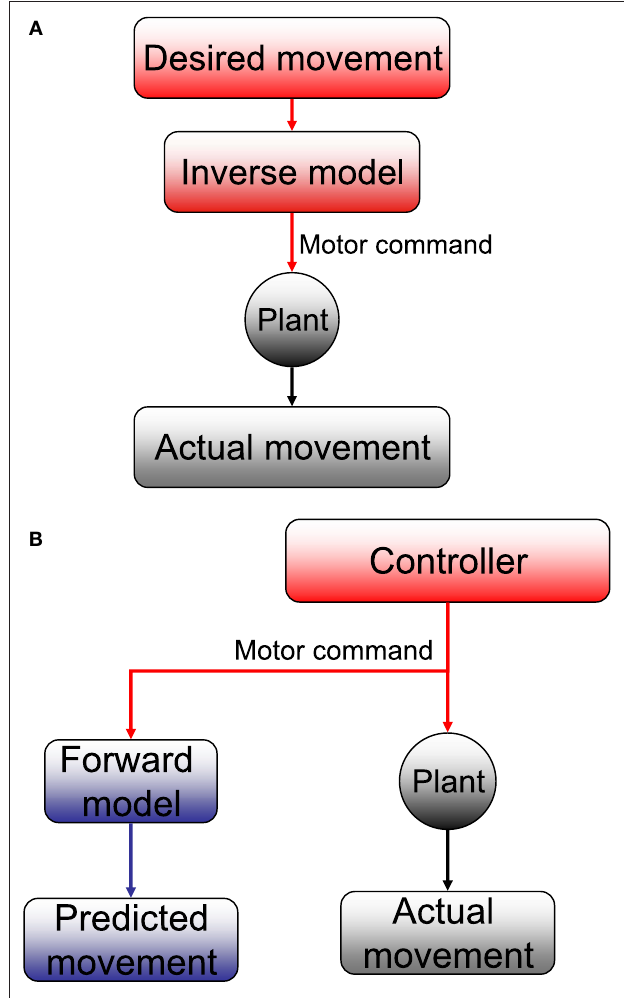
FIGURE 2 | (A) Inverse and (B) forward models. The plant takes motor commands and produces movement. The inverse model inverts this process, producing the motor commands that are appropriate for a given movement. A forward model mimics this process, estimating the movement that will be produced by the